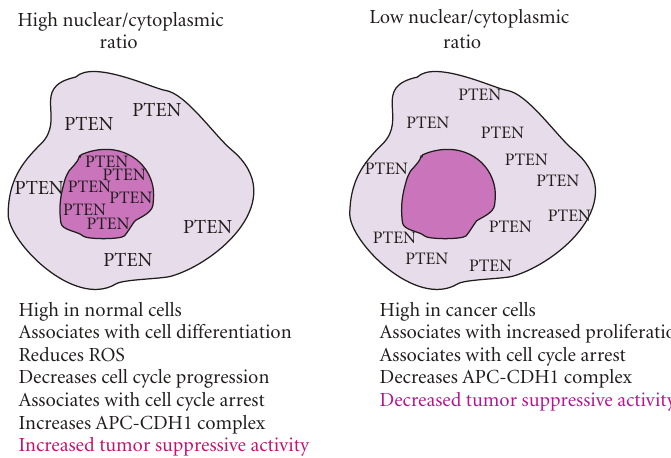
Figure 2: Cell-characteristics associated with the presence or absence of nuclear